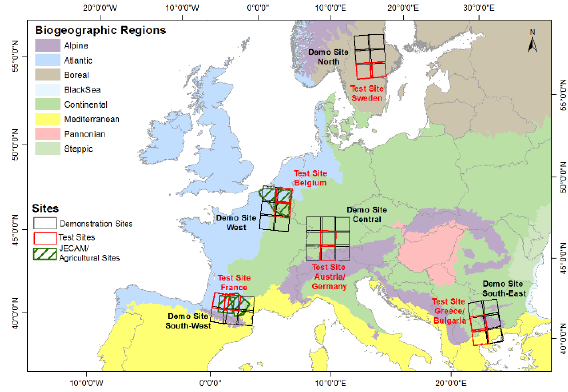
Figure 1. ECoLaSS Sites distribution in Europe